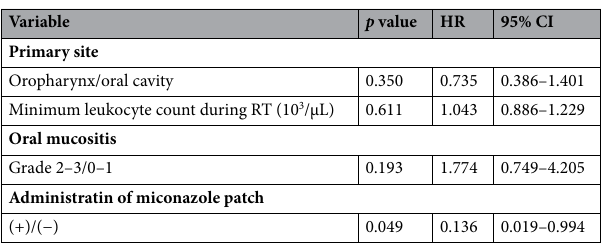
Table 3. Factors related to the development of oral candidiasis (multivariate cox regression